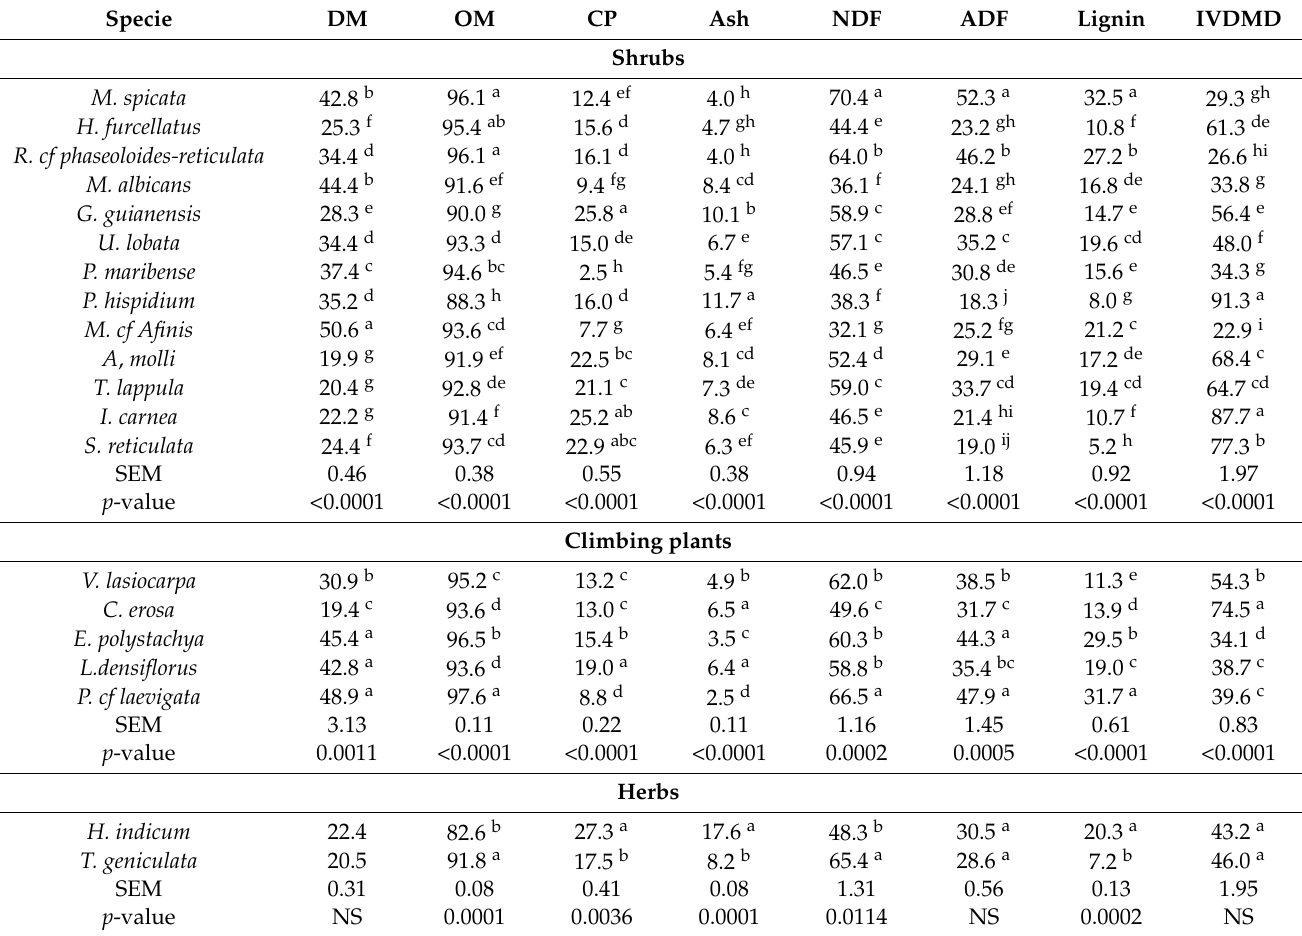
Table 3. Nutritional characteristics (%) of the evaluated shrubs, climbing and herb plants on dry matter